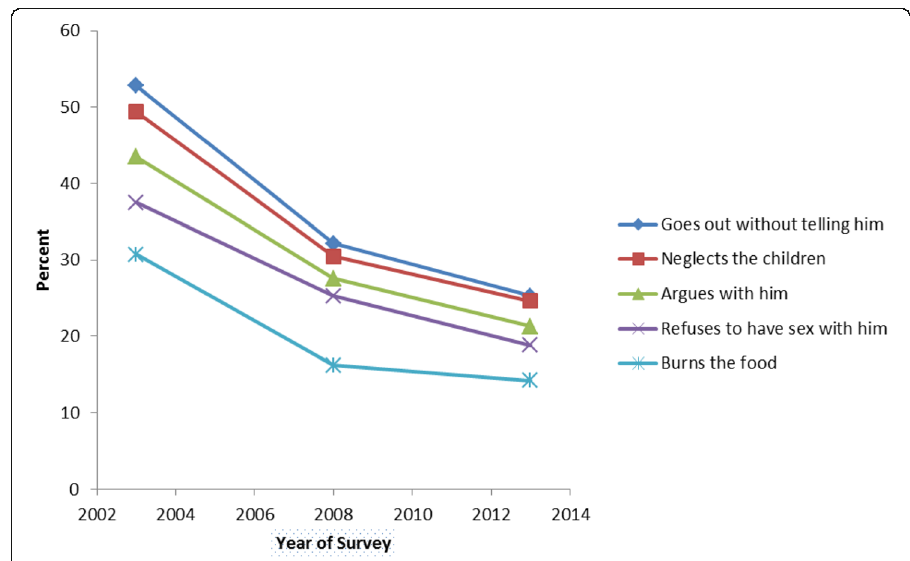
Fig. 1 Percentage of women justifying wife-beating by hypothetical reason in Nigeria from 2003 to